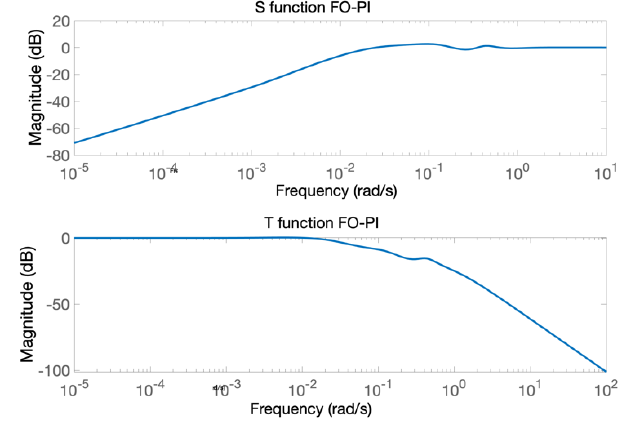
Figure 10. FO-PI sensitivity measures.